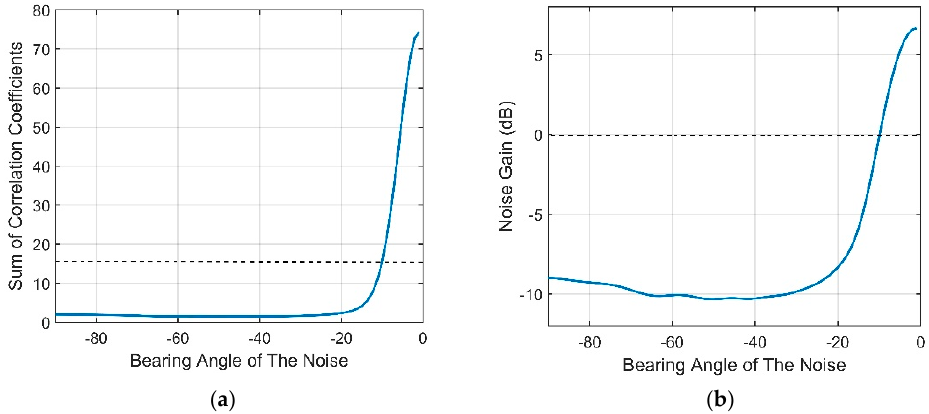
Figure 15. ( a ) The sum of the correlation coefficients for different noise directions; ( b ) the NG for different noise directions.